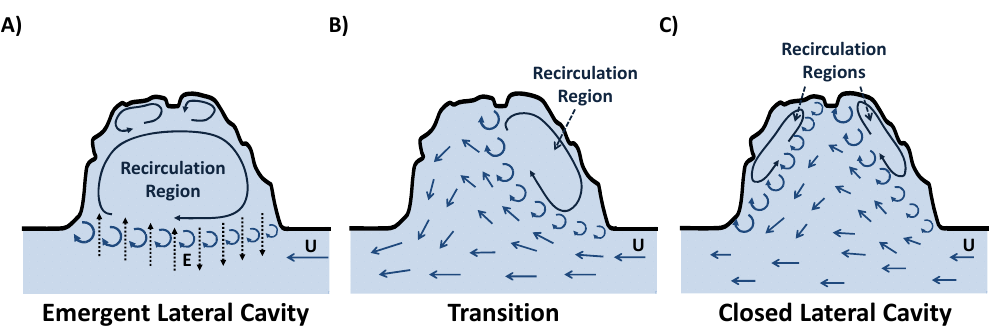
Fig. 11. Schematics showing the evolution of the flow field from an emergent lateral cavity (A) to a closed lateral cavity (C) .